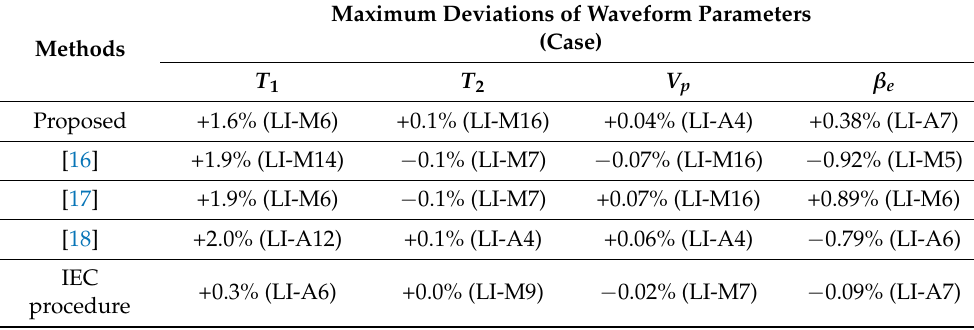
Table 2. The comparison of the maximum deviations of the waveform parameters determined by the proposed and other non-iterative methods.